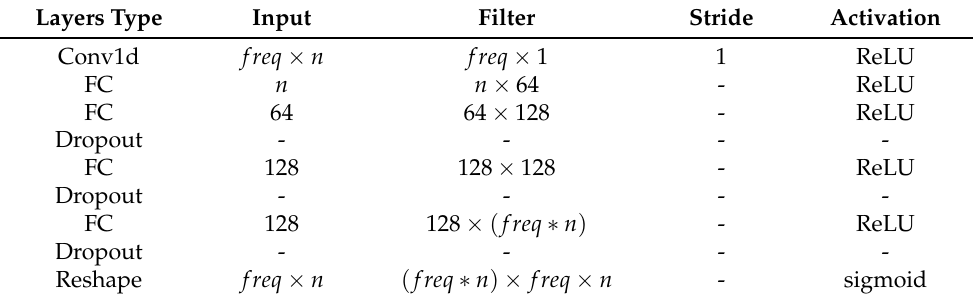
Table 1. Architecture of the trigger generation